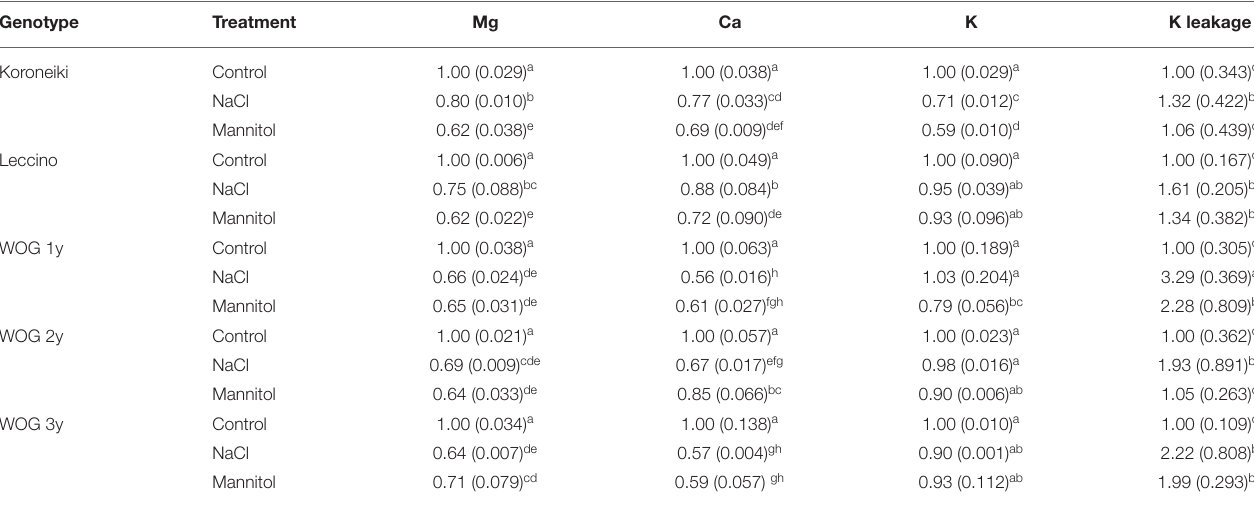
TABLE 3 | The relative ion content and K leakage of olive